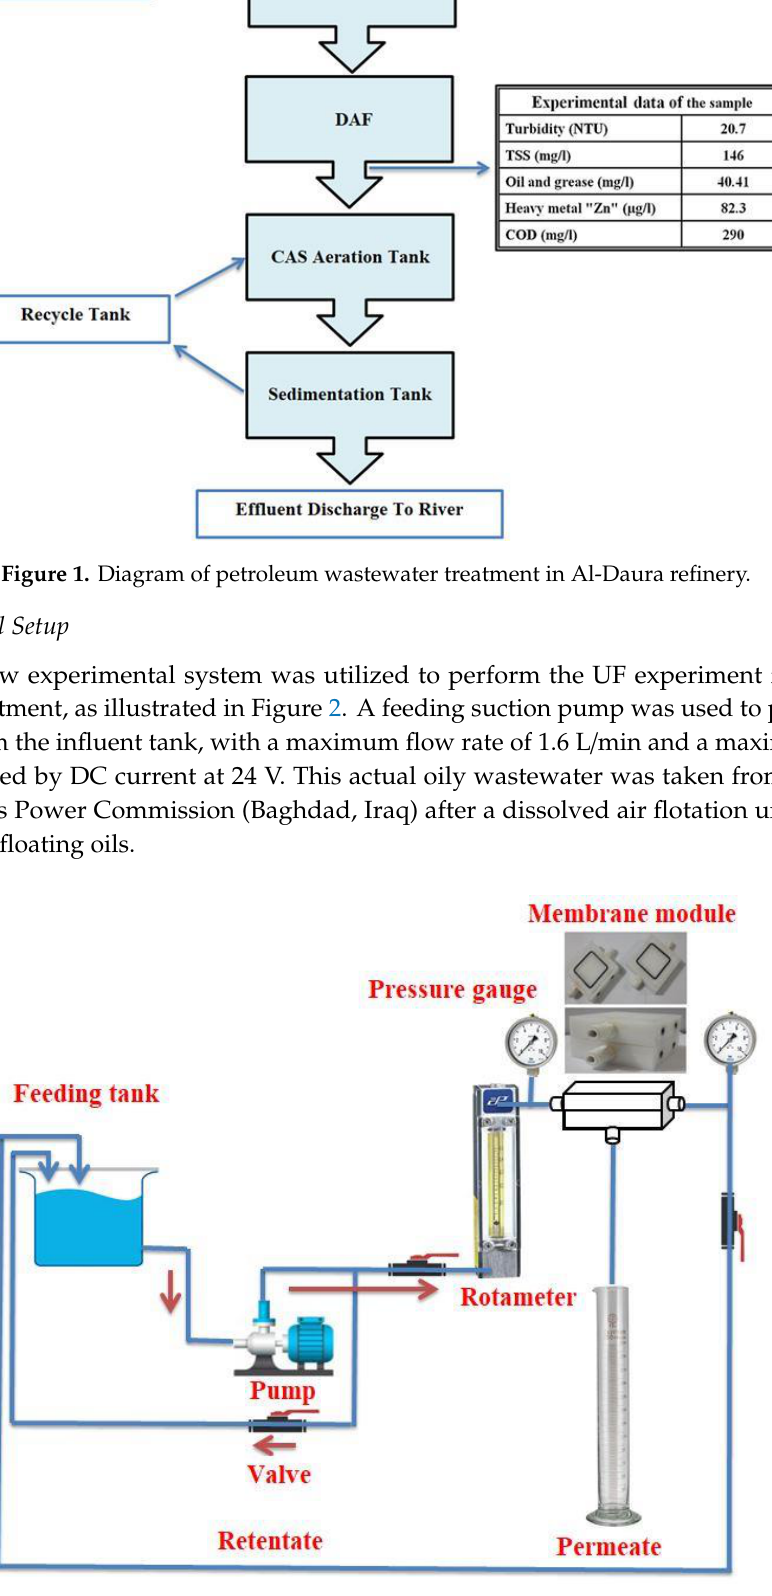
Figure 2. Schematic diagram of ultrafiltration membrane (UF) experimental system.